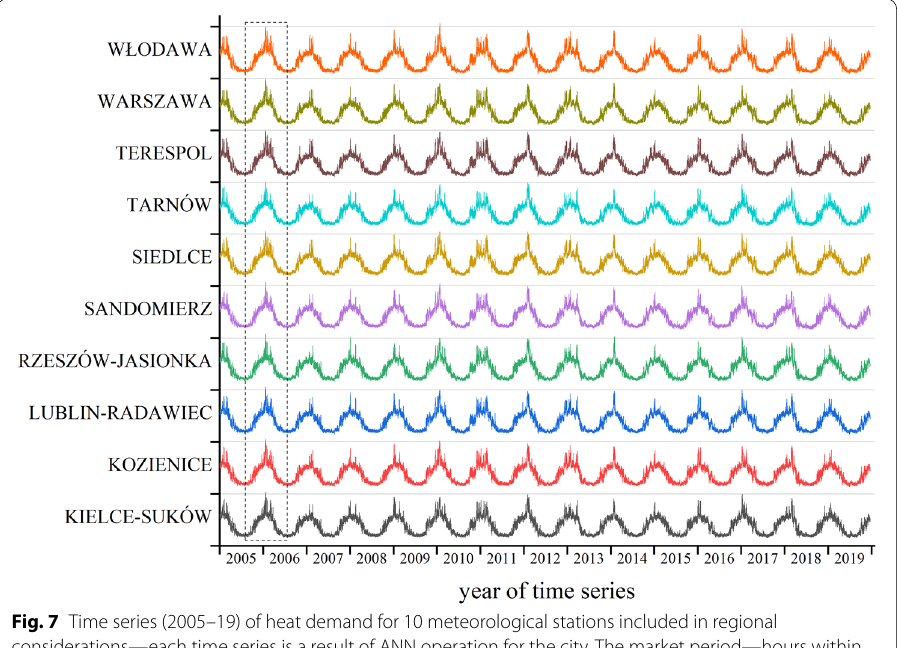
considerations—each time series is a result of ANN operation for the city. The market period—hours within dashed lines are presented in Fig. 9. X axis denotes consecutive hours of the dataset; Y axis marks cities. For each city the scale is from 0 to 1. Time series has been generated based on ANN model presented in